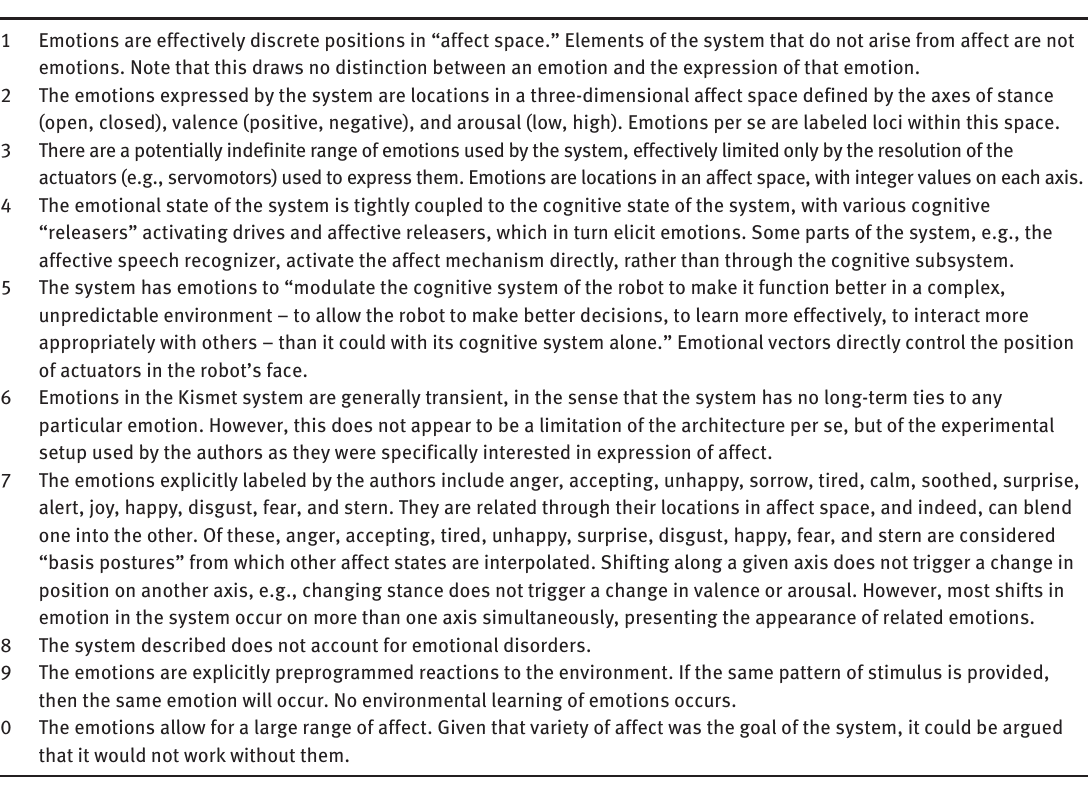
Table 4. Classification of KISMET [3].